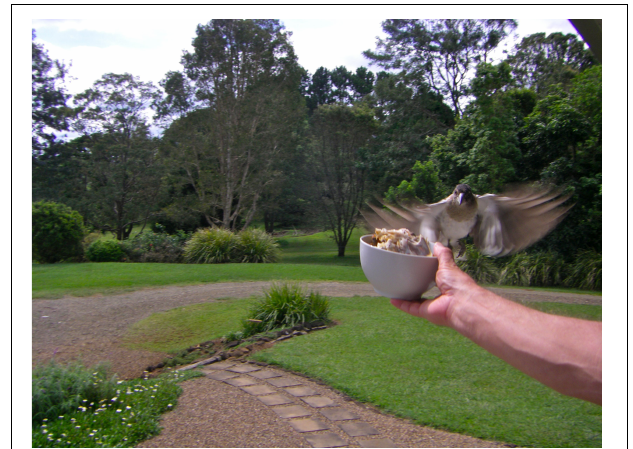
FIGURE 1 | An immature pied butcherbird flying in to feed at the Maleny